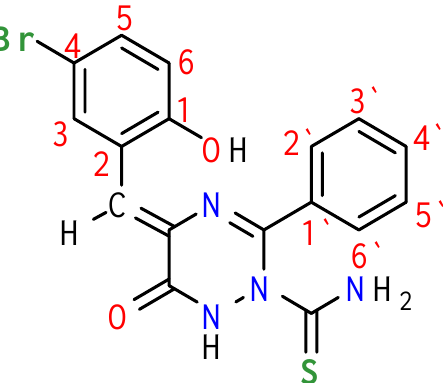
Figure 1. Numerical structure of compound 4.